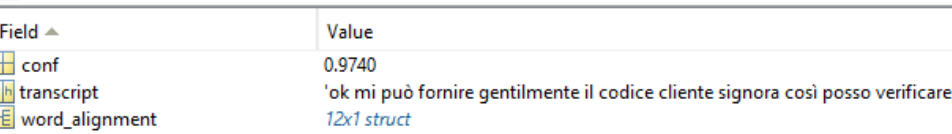
Figure 3. Segment 8 of 26 id Agent in transcription 18 of 993. The Italian for the text: “ok, can you kindly provide me the customer code ma’am, so I can check”.